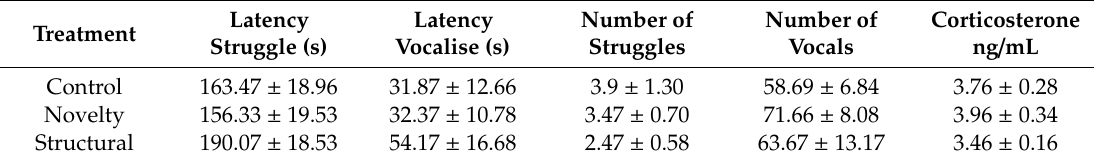
Table 3. The mean ± SEM of latencies to struggle and vocalise (seconds), numbers of struggles and vocalisations, and plasma corticosterone concentrations during a manual restraint test for pullets from three rearing enrichment treatments (control: n = 30, novelty: n = 30, structural: n = 30).